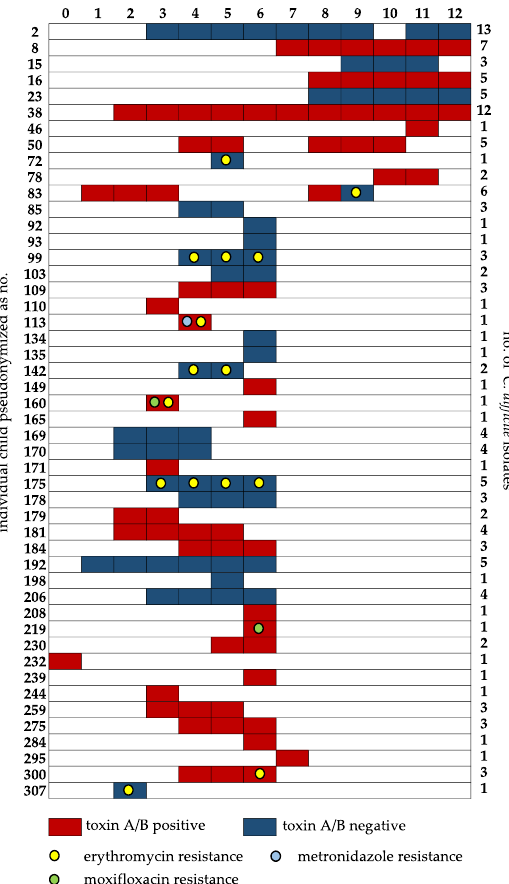
Figure 1. Overview of the presence of C. difficile strains, toxin A/B genes and antibiotic resistance over time. The left axis indicates the pseudonymized child number. The number on the right axis denotes the total number of isolated strains from that child. Strain presence is indicated by colored boxes. Toxin A/B-positive strains are colored red; negative strains are colored blue. Antibiotic resistances are indicated as colored dots. Note: Only in child 83, a switch from previously toxin A/B-positive isolates to toxin A/B-negative isolates, which showed erythromycin resistance, occurred from month 8 to month 9. In child 300, there was a switch to erythromycin-resistant and toxin A/B-positive isolates at month 6. All other children showed a constancy in colonization regarding the examined parameters.